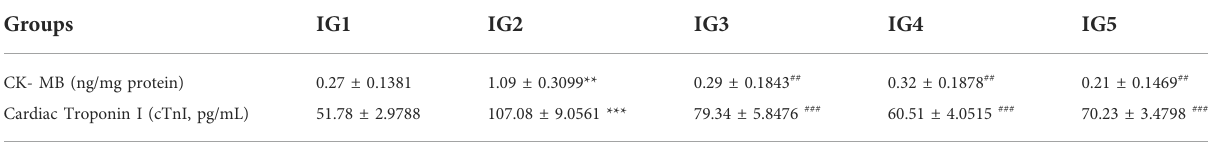
TABLE 2 Effect of ISO and GC pre- treatment on CK- MB (ng/ml) levels in the heart tissue homogenates and cardiac troponin I (cTnI) in serum.